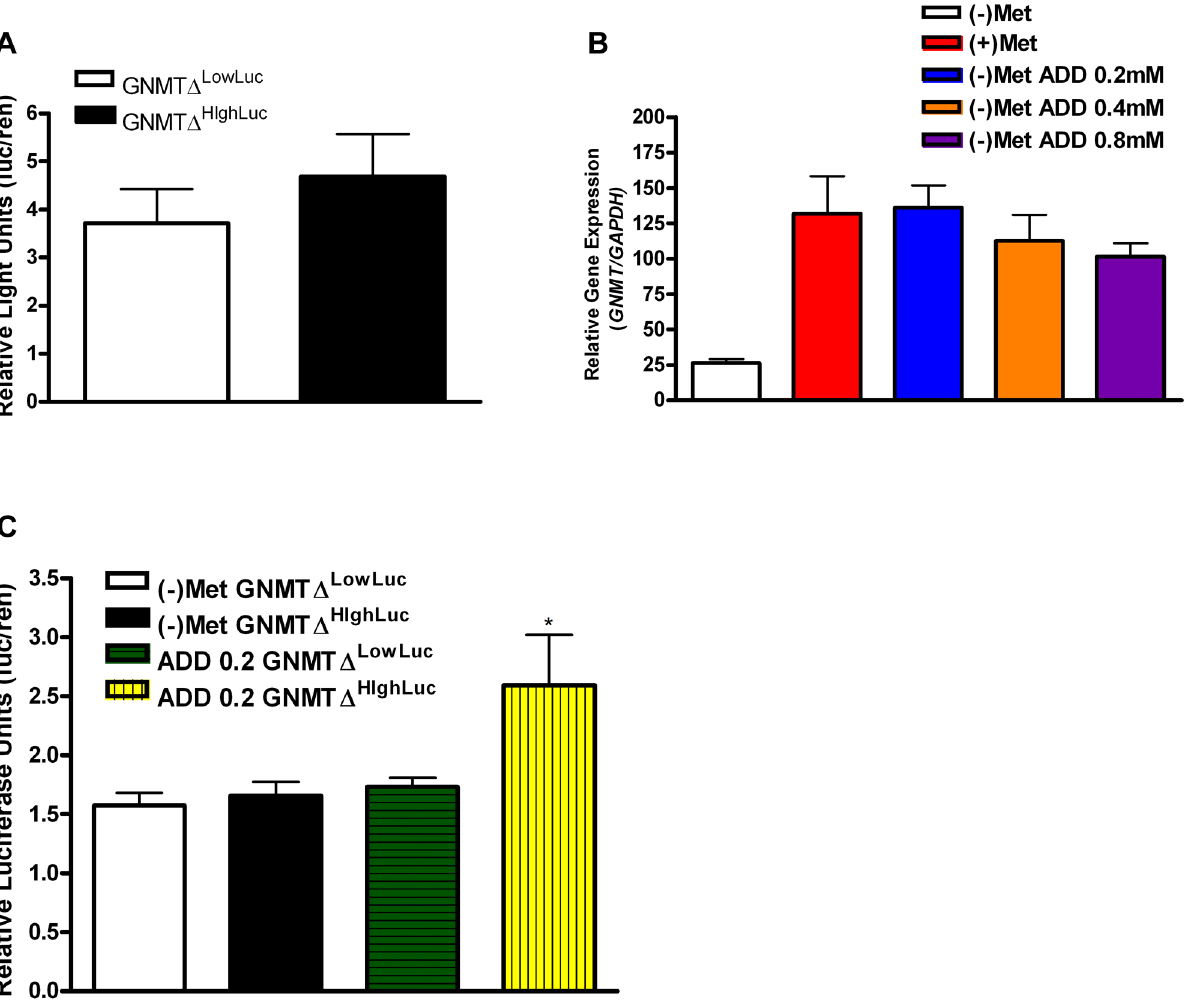
Figure 3. GNMT promoter analysis of major haplotype groups. (A) Histogram shows mean luciferase activity of the high-methionine- metabolizing haplotype (TCCGGAT) and the low-methionine-metabolizing haplotype (CGTCTGC) represented by constructs GNMT D HighLuc and GNMT D LowLuc cultured in standard DMEM with L-methionine (0.2 mM). (B) Shows GNMT qPCR analysis in HepG2 cells. Culturing conditions are as follows: ( + )Met=standard complete DMEM cultured for 48 hours, ( 2 )Met=complete DMEM without L-Methionine culture for 48 hours, ( 2 )Met ADD 0.2=DMEM without L-Methionine culture for 24 hours, addition of L-Methionine at 0.2 mM for 24 hours, ( 2 )Met ADD 0.4=DMEM without L-Methionine culture for 24 hours, addition of L-Methionine at 0.4 mM for 24 hours, ( 2 )Met ADD 0.8=DMEM without L-Methionine culture for 24 hours, addition of L-Methionine at 0.8 mM for 24 hours. (C) ( 2 )Met GNMT D HighLuc and ( 2 )Met GNMT D LowLuc represent HepG2 cells transfected with GNMT D HighLuc and GNMT D LowLuc constructs and cultured without L-methionine for 48 hours. ADD 0.2 GNMT D LowLuc and ADD 0.2 GNMT D HighLuc represent HepG2 cells transfected with GNMT D HighLuc and GNMT D LowLuc constructs cultured without L-methionine for 24 hours and with 0.2 mM L-methionine for 24 hours. * P , 0.05 by students t-test. N=3 biological replicates for all analyses. Error bars represent standard deviation from the mean (SD).